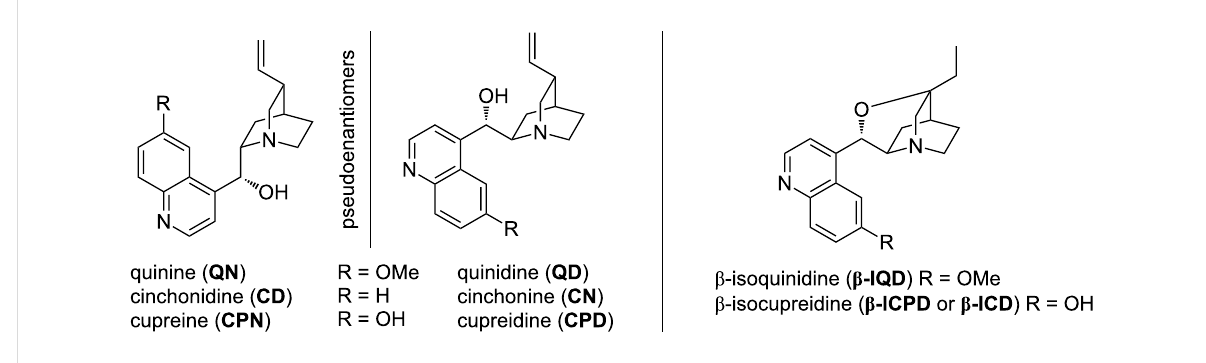
Figure 1: The structural diversity of the cinchona alkaloids, along with cupreine, cupreidine, β -isoquinidine and β -isocupreidine derivatives.